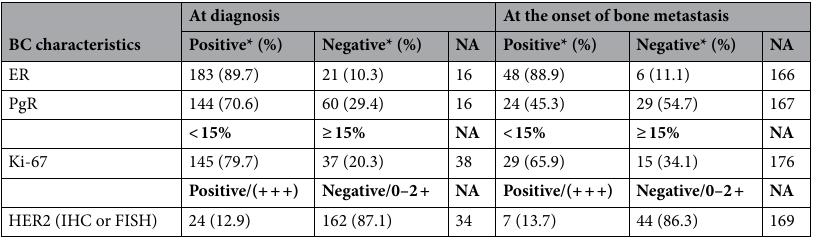
Table 2. Biomarker characteristics at diagnosis of primary BC and at onset of BM. BC breast cancer, BM bone metastasis, ER oestrogen receptor, PgR progesterone receptor, NA not available, IHC immunohistochemistry, FISH fluorescence in situ hybridisation. *For ER and PgR, positive if ≥ 10%, negative if <